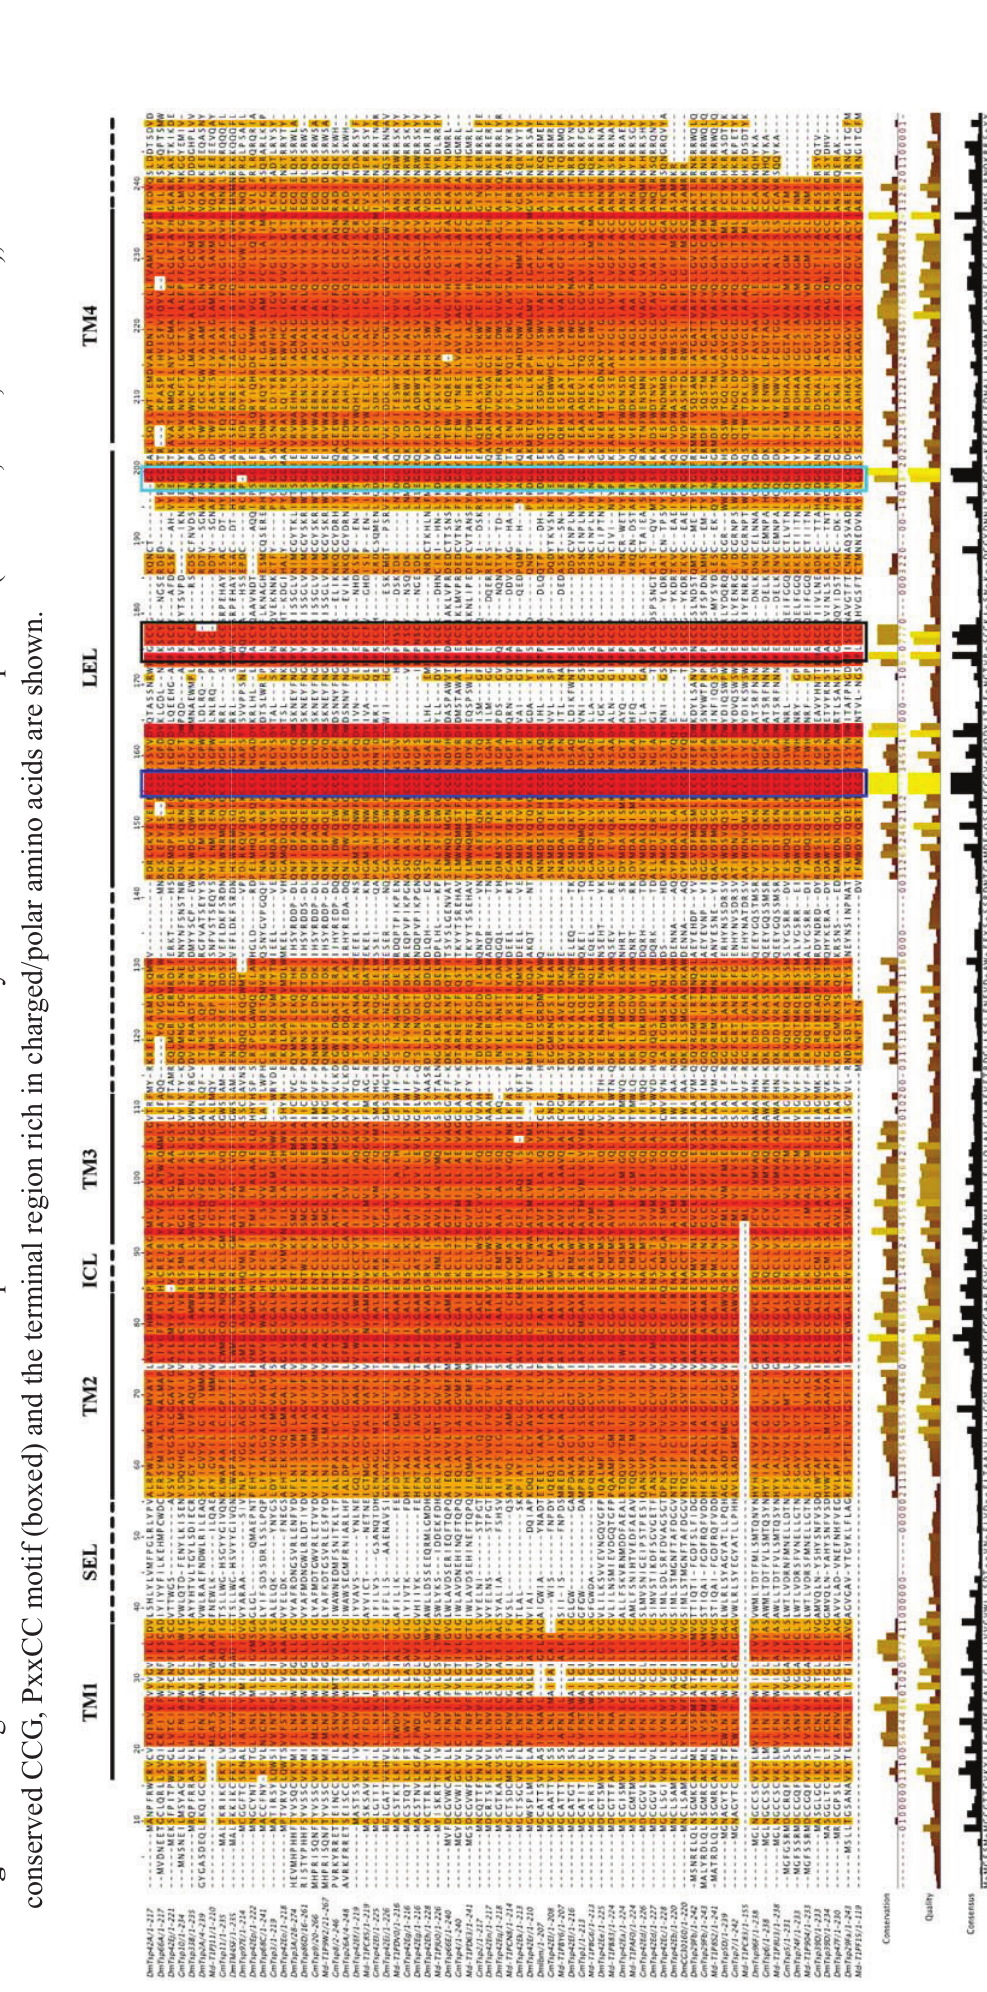
5 2014 , s ec t s n I